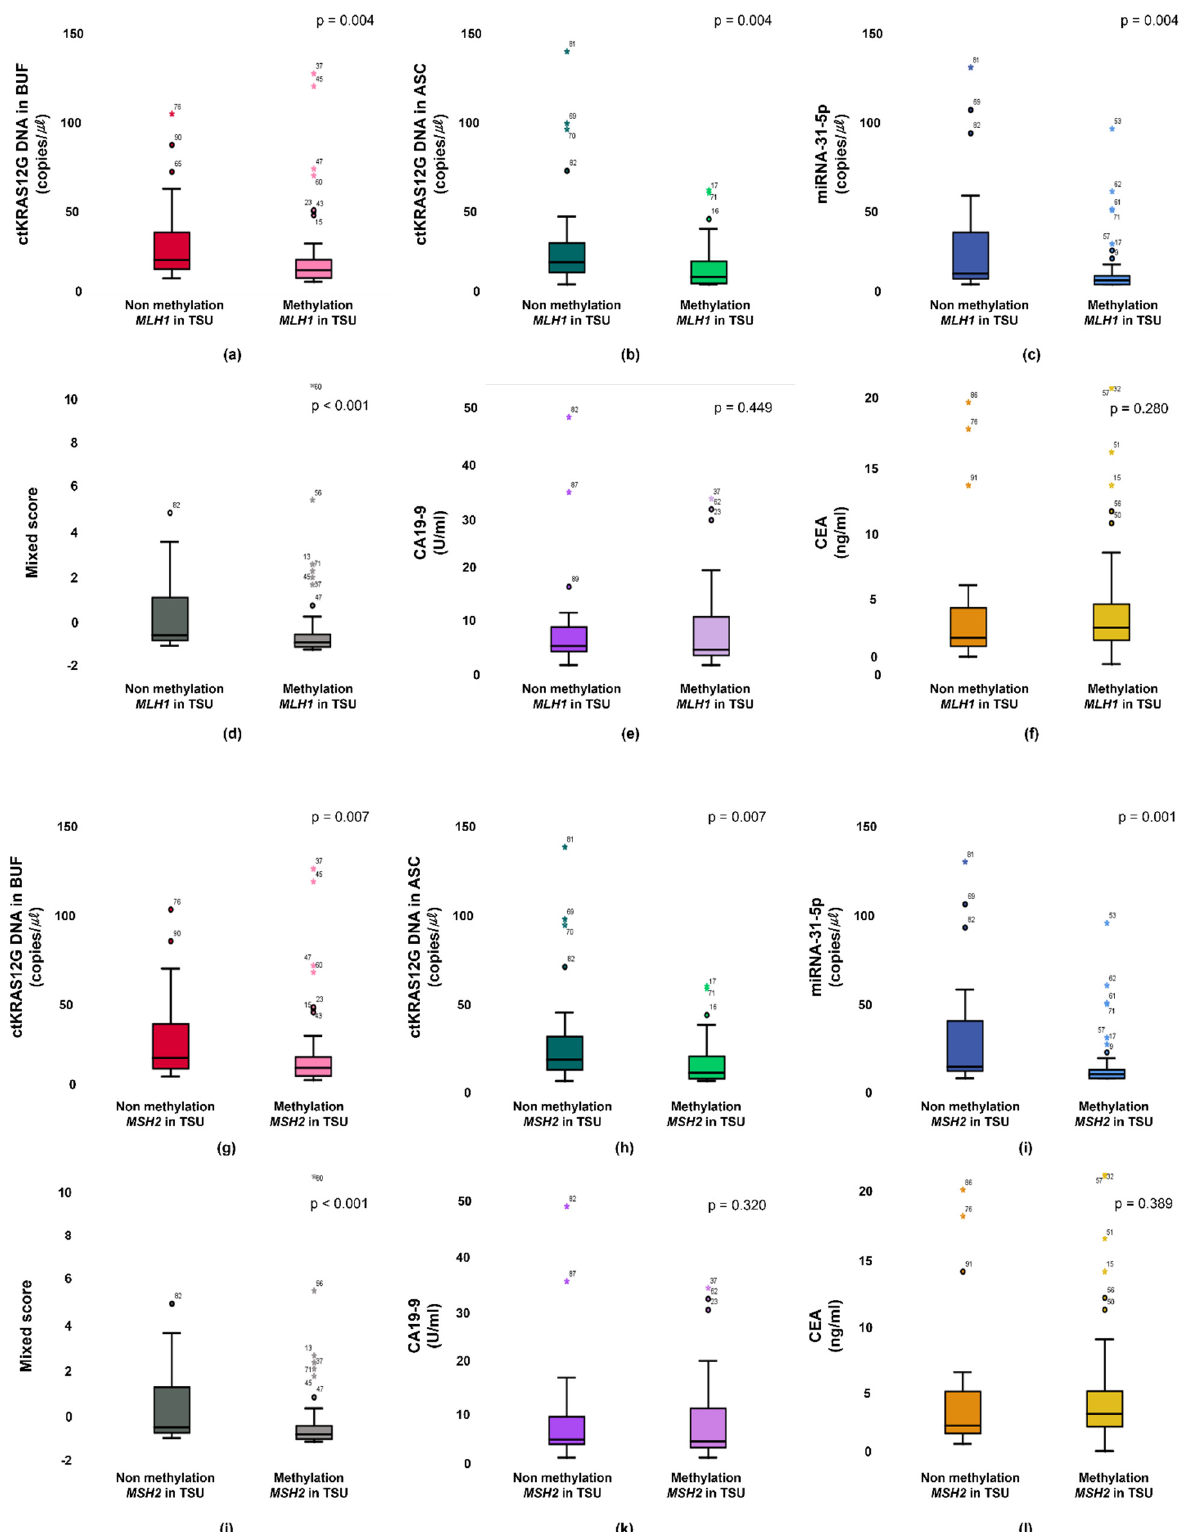
Figure 5. Primary status between methylation and non-methylation of MLH1 are associated from the buffy coat ( a ), ascites ( b ), miR-31-5 ( c ), mixed score ( d ), CEA ( e ), and CA19-9 ( f ). Primary status between methylation and non-methylation of MSH2 are associated from the buffy coat ( g ), ascites ( h ), miR-31-5 ( i ), mixed score ( j ), CEA ( k ), and CA19-9 ( l ).